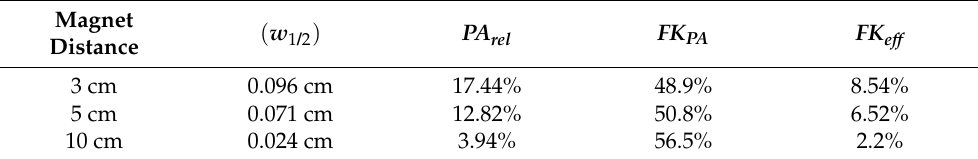
Table 8. Comparison of calculated values of treatment efficacy parameters at different distances between the magnetic source and the center of the tumor 60 min after IP injection.